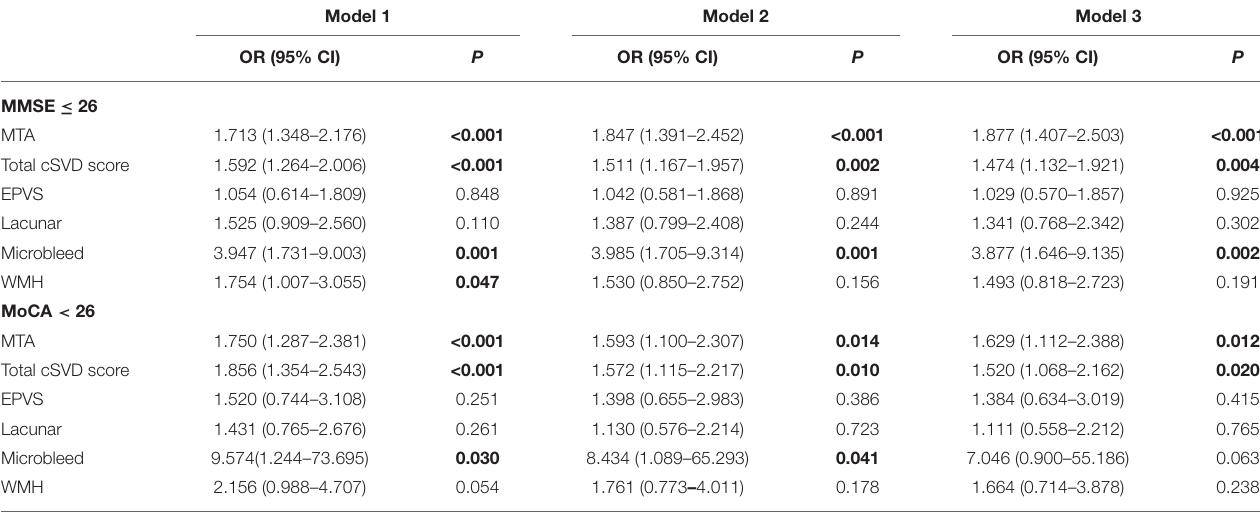
TABLE 5 | MTA and cSVD in relation to cognitive status by regression